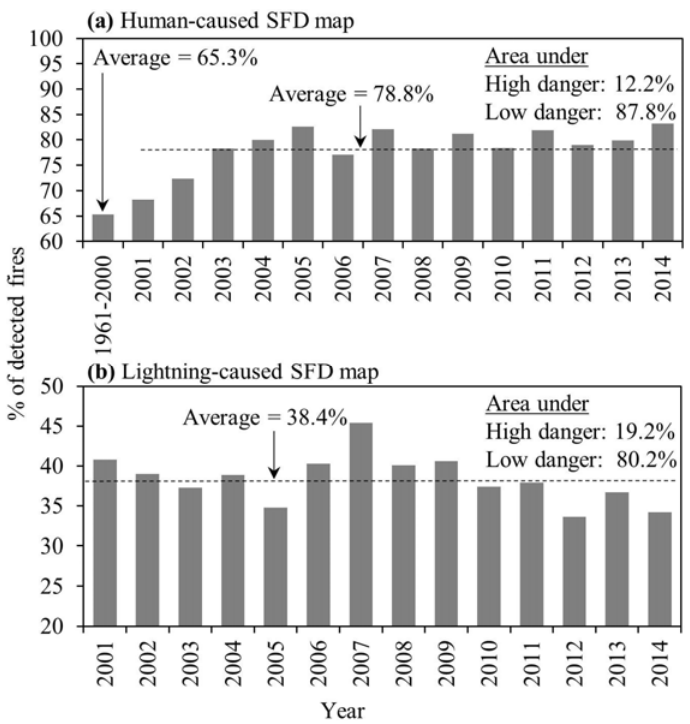
Figure 5. Dynamics of human- and lightning-caused SFD maps in terms of their percentage of detected fires and percentage of area under each of the danger classes.